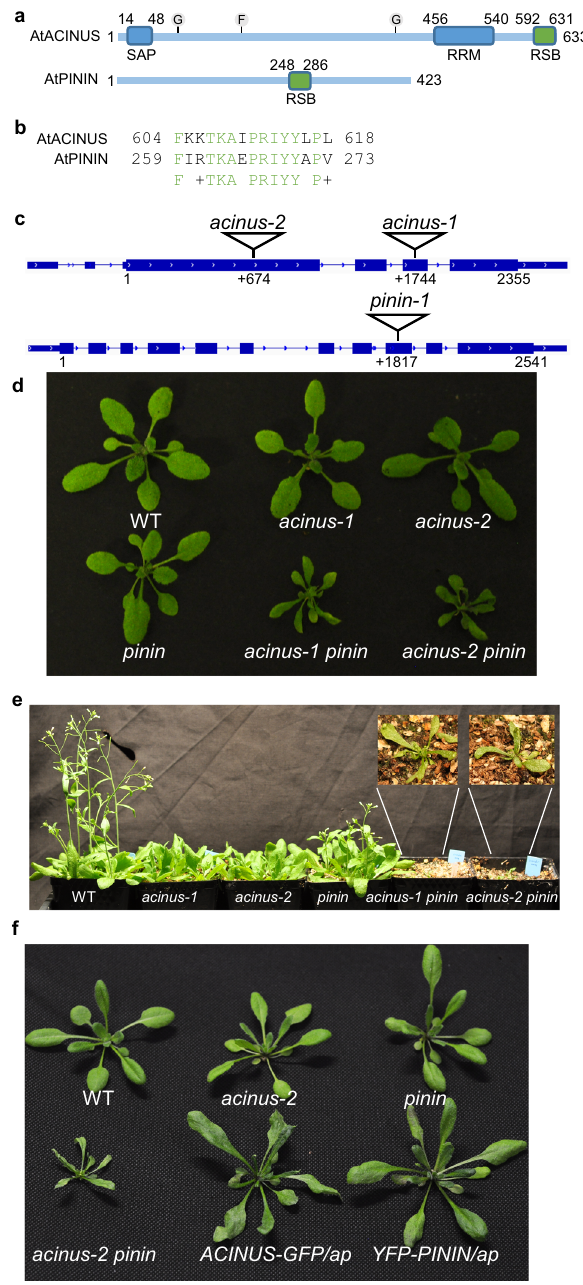
Fig. 1 AtACINUS and AtPININ are genetically redundant. a Diagrams of the domain structures of AtACINUS and AtPININ. SAP: SAF-A/B, Acinus, and PIAS motif. RRM: RNA-recognition motif. RSB: RNPS1 – SAP18 binding domain. G and F indicates the position of O-GlcNAcylation and O- fucosylation modi fi cations, respectively. b The sequence alignment of the RSB domains of AtACINUS and AtPININ. Conserved amino acids are highlighted in green. c Diagrams of the AtACINUS and AtPININ (translation start at position 1) with T-DNA insertion sites in acinus-1 , acinus-2 , and pinin-1 mutants. d Plant morphologies of wild-type (WT), acinus-1 , acinus-2, pinin-1 , acinus-1 pinin-1 , and acinus-2 pinin-1 grown on soil for 20 days. e Five- week-old WT, acinus-1 , acinus-2 , pinin-1 , acinus-1 pinin-1 , and acinus-2 pinin-1 plants grown under long day condition. Inset shows enlarged view of the acinus -1 pinin-1 and acinus-2 pinin-1 mutants. f Expression of either AtACINUS-GFP or YFP-AtPININ suppresses the growth defects in acinus-2 pinin-1 double mutant ( ap ). NATURE COMMUNICATIONS| (2021) 12:945 |https://doi.org/10.1038/s41467-021-20929-7|www.nature.com/naturecommunications